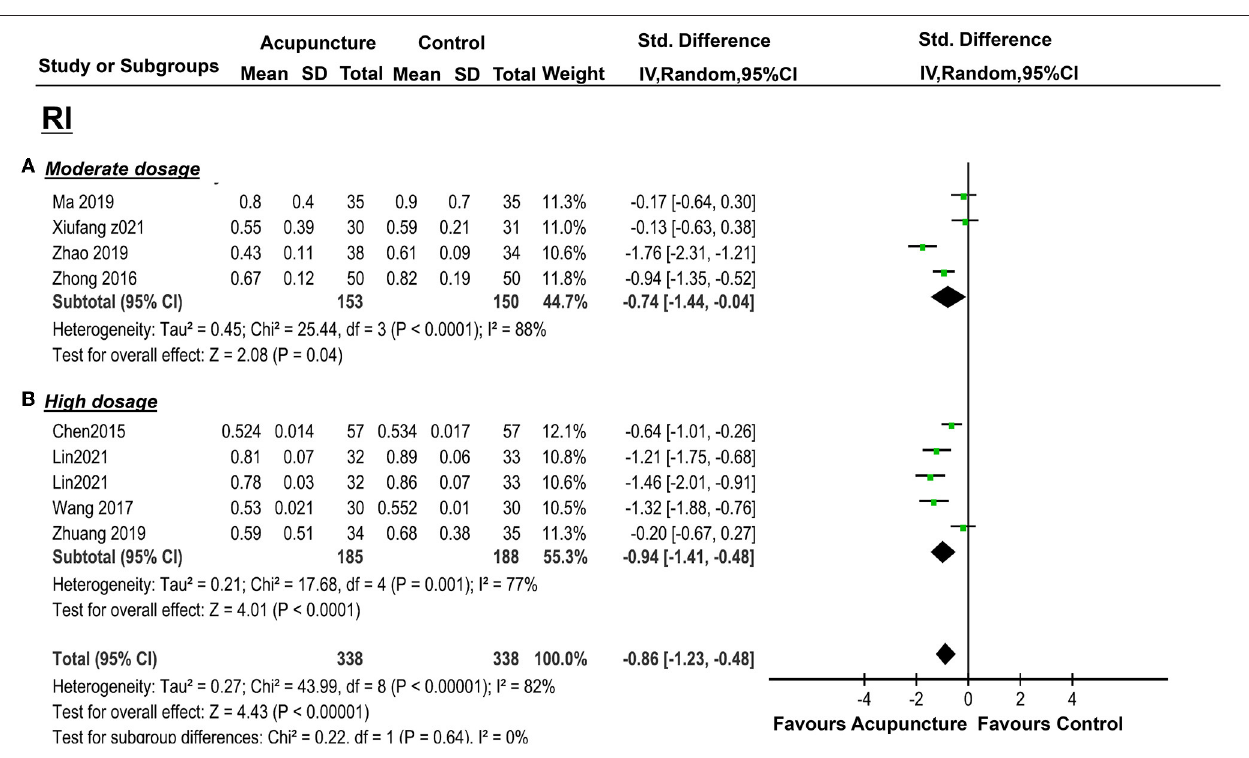
Frontiers in Public Health |